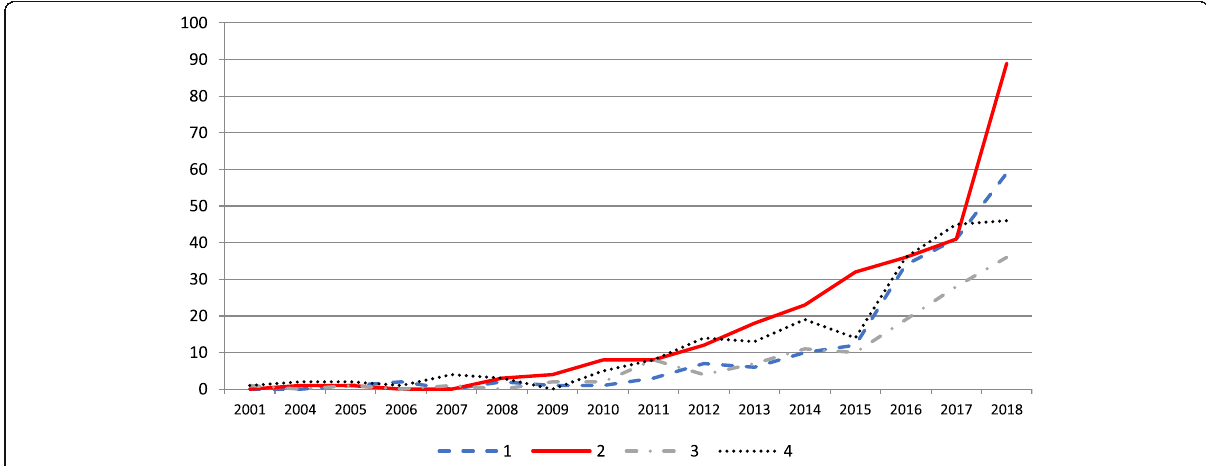
Fig. 13 Publication distributions in terms of research methods over the years. (Note: 1=qualitative, 2=quantitative, 3=mixed,